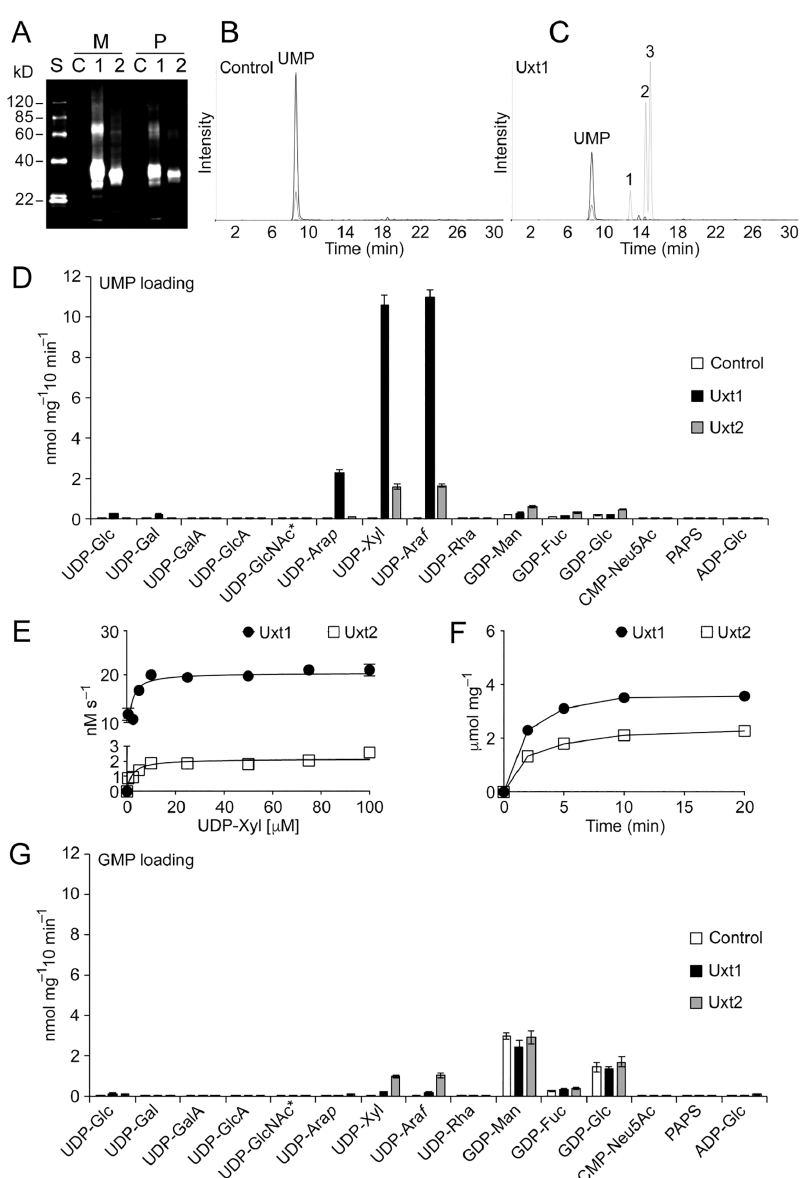
Fig 2. Uxt1 and Uxt2 in vitro transport activities. (A) Immunoblotanalysisof microscomes (M) and proteoliposomes (P) preparedfrom S . cerevisiae expressingvector alone (Control) or V5-taggedUxt1 or Uxt2 (2.5 μ g protein per lane; S, standards; C, control; 1, Uxt1; 2, Uxt2). (B and C) Representative LC-MS/MS spectra of proteoliposomes preparedfrom (B) control or (C) Uxt1-expressing S . cerevisiae cells, preloaded with 30 mM UMP, and incubatedwith a mixture of 16 nucleotide / nucleotide sugar substrates (50 μ M each, 10 min, 37˚C); Peak 1, UDP-Ara p ;Peak 2, UDP-Xyl; Peak 3, UDP-Ara f . (D) Nucleotidesugar uptake into proteoliposomes preloadedwith 30 mM UMP. Valueswere normalized to the total protein content of the proteoliposome preparations. Data represent the mean ± SD of n = 4 assays. * , mixture of UDP-GalNAc and UDP-GlcNAc. (E and F) Proteoliposomes preloadedwith 10 mM UMP were incubatedfor 2 min with UDP-Xyl (E) at variableconcentrations (0–100 μ M) or (F) for the indicatedtimes with 50 μ M UDP-Xyl. Values were normalized to the actual NST content in proteoliposome preparations (S4 Table). Data are the mean ± SEM of n = 4 assays. (G) Nucleotidesugar uptake into proteoliposomes preloadedwith 30 mM GMP analyzedas in